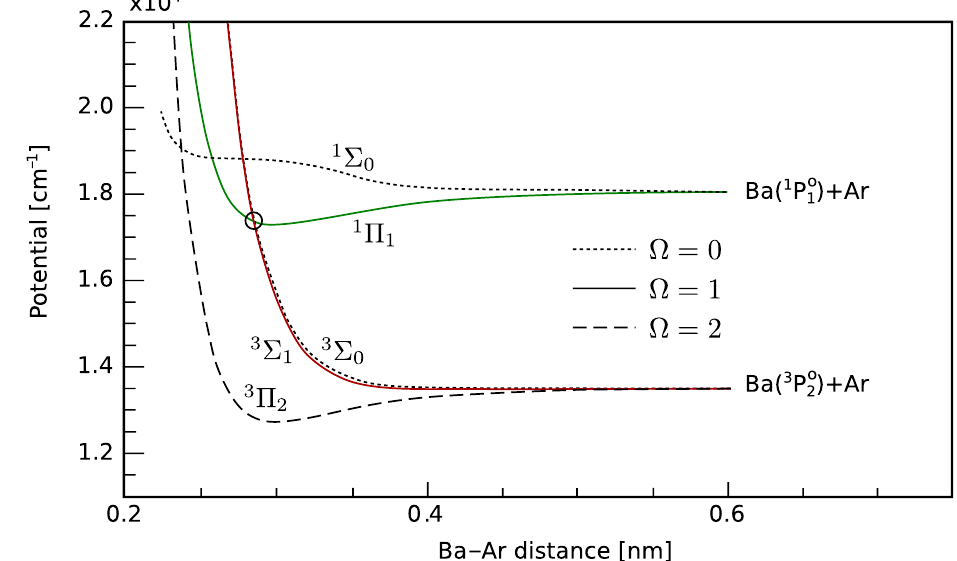
Figure 1. Diabatic potential curves in the barium–argon system. The level crossing indicated by a circle is responsible for the population transfer between the 1 P o with permission from [21]. 1992, American Physical